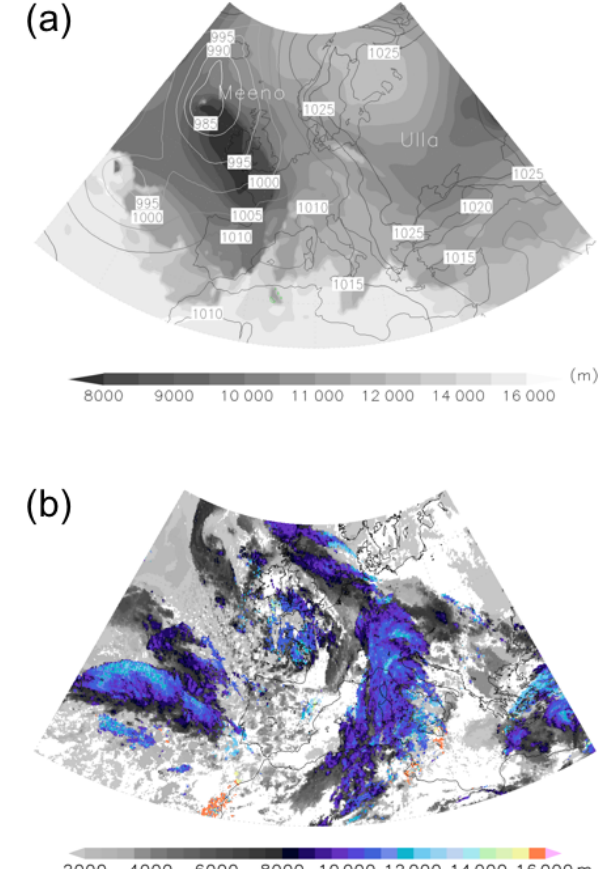
Figure 14. Panel (a) : mean sea level pressure (contours) and tropopause height (shaded contours) over Europe from GFS anal- yses on 25 October 2011 at 18:00UTC. Panel (b) : cloud top height from MSG data on 25 October 2011 at